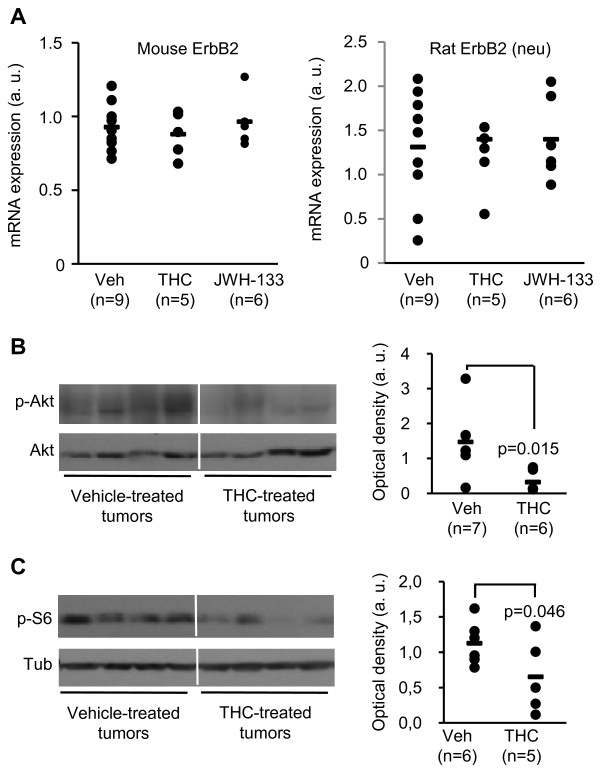
THC inhibits Akt in vivo. (A) Mouse ErbB2 and (B) rat ErbB2 (neu transgene) mRNA expression in vehicle- and cannabinoid-treated tumors as determined by real-time quatitative PCR. (B and C) Western blot and densitometric analysis of phospho-Akt (B) and phospho-S6 ribosomal protein (C) levels in MMTV-neu-derived tumors treated with vehicle or THC. Eight representative tumors are shown. Total Akt (B) and α-tubulin (C) were used for normalization. Non-contiguous parts of the same gel are shown. Optical densities are expressed in arbitrary units.